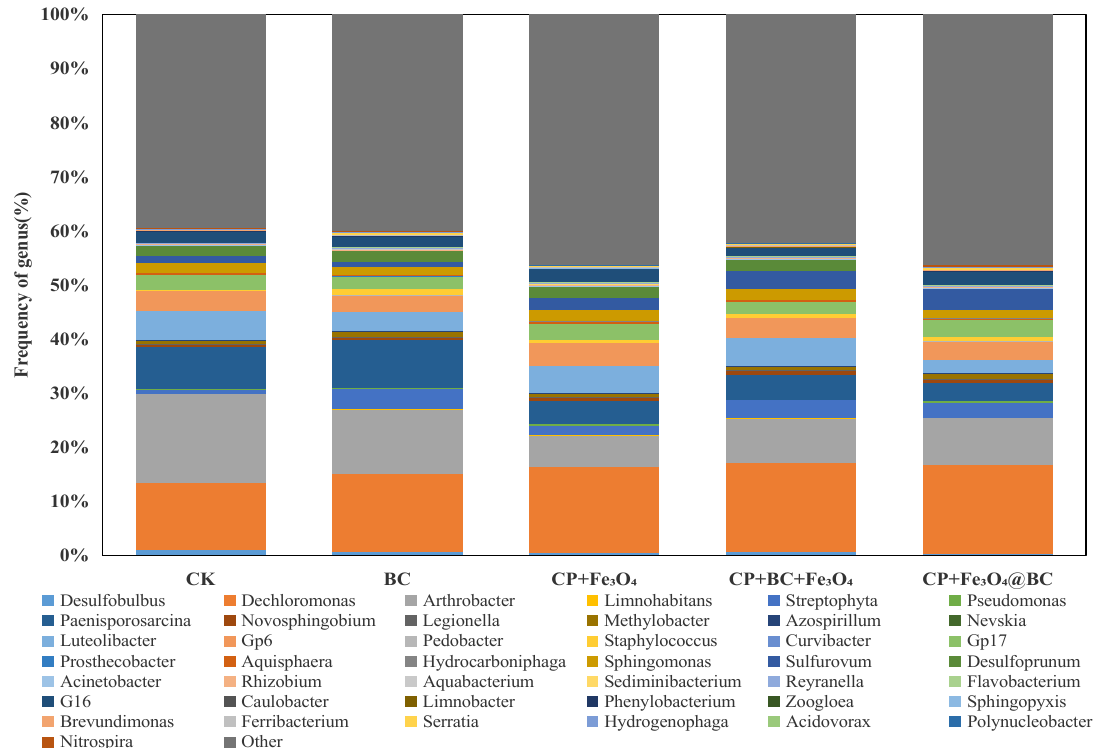
Figure 8. The relative abundance of microbial communities. Sulfurovum can obtain energy by oxidizing AVS [38]. Compared with CK group, Sulfurovum abundance of the CP+Fe 3 O 4 group, CP+BC+Fe 3 O 4 group and CP+Fe 3 O 4 @BC group increased to 0.9%, 1.5% and 1.7%, respectively. Sulphate-reducing bacteria (SRBs) use oxidized sulfur compounds as electron acceptors and produce sulfide while oxidizing organics for energy generation. As a type of SRB, Desulfobulbus content in the CK group and BC group were 0.45% and 0.31%, respectively, but the Desulfobulbus content in the CP+Fe 3 O 4 group, CP+BC+Fe 3 O 4 group and CP+Fe 3 O 4 @BC group is 0.21%, 0.3% and 0.13%, respectively. Therefore, the introduction of CP and Fe 3 O 4 @BC composite materials can inhibit the growth of SRB and promote the growth of sulfur oxidizing bacteria, which can remove AVS [39].